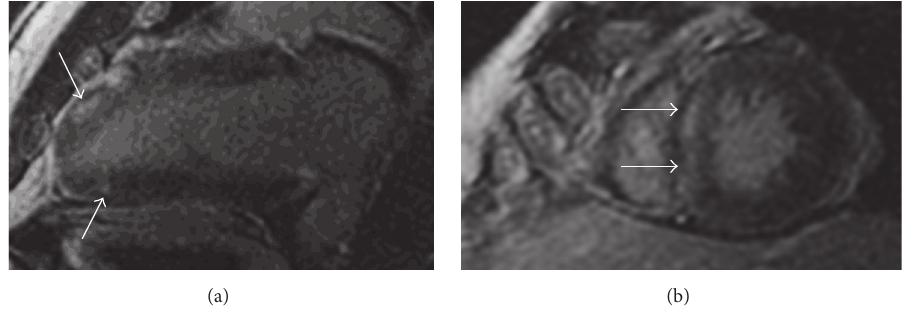
Figure 5: Cardiac magnetic resonance imaging with demonstration of patchy and some full-thickness late gadolinium enhancement of the (a) distal anteroapical wall segments, inferoapical segment, and (b) mid septum